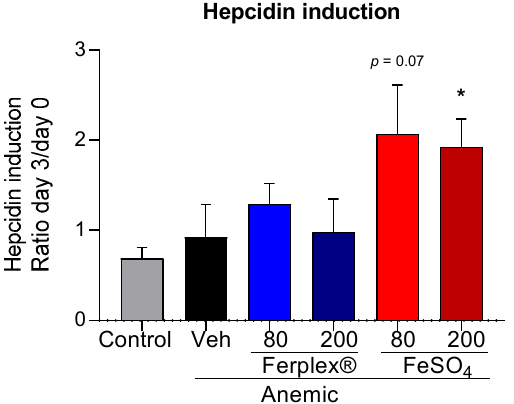
Figure 8. Hepcidin induction calculated as the ratio between the concentration of serum hepcidin measured in serum on day 3 and on day 0 of the treatment via an ELISA assay. * p < 0.05, as compared with the control group by means of a Kruskal-Wallis test, followed by Dunnett’s multiple comparison test. N = 5 (FeSO 4 200); 7 (control); 8 (Ferplex ® 80); 6 (remaining groups). Veh = vehi- cle.